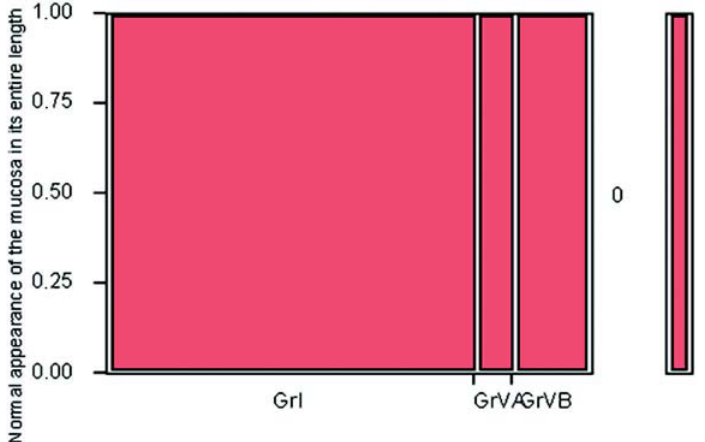
Figure 6- Macroscopic observation of the gastric mucosa in relation to parameter - Normal appearance of the mucosa in its entire